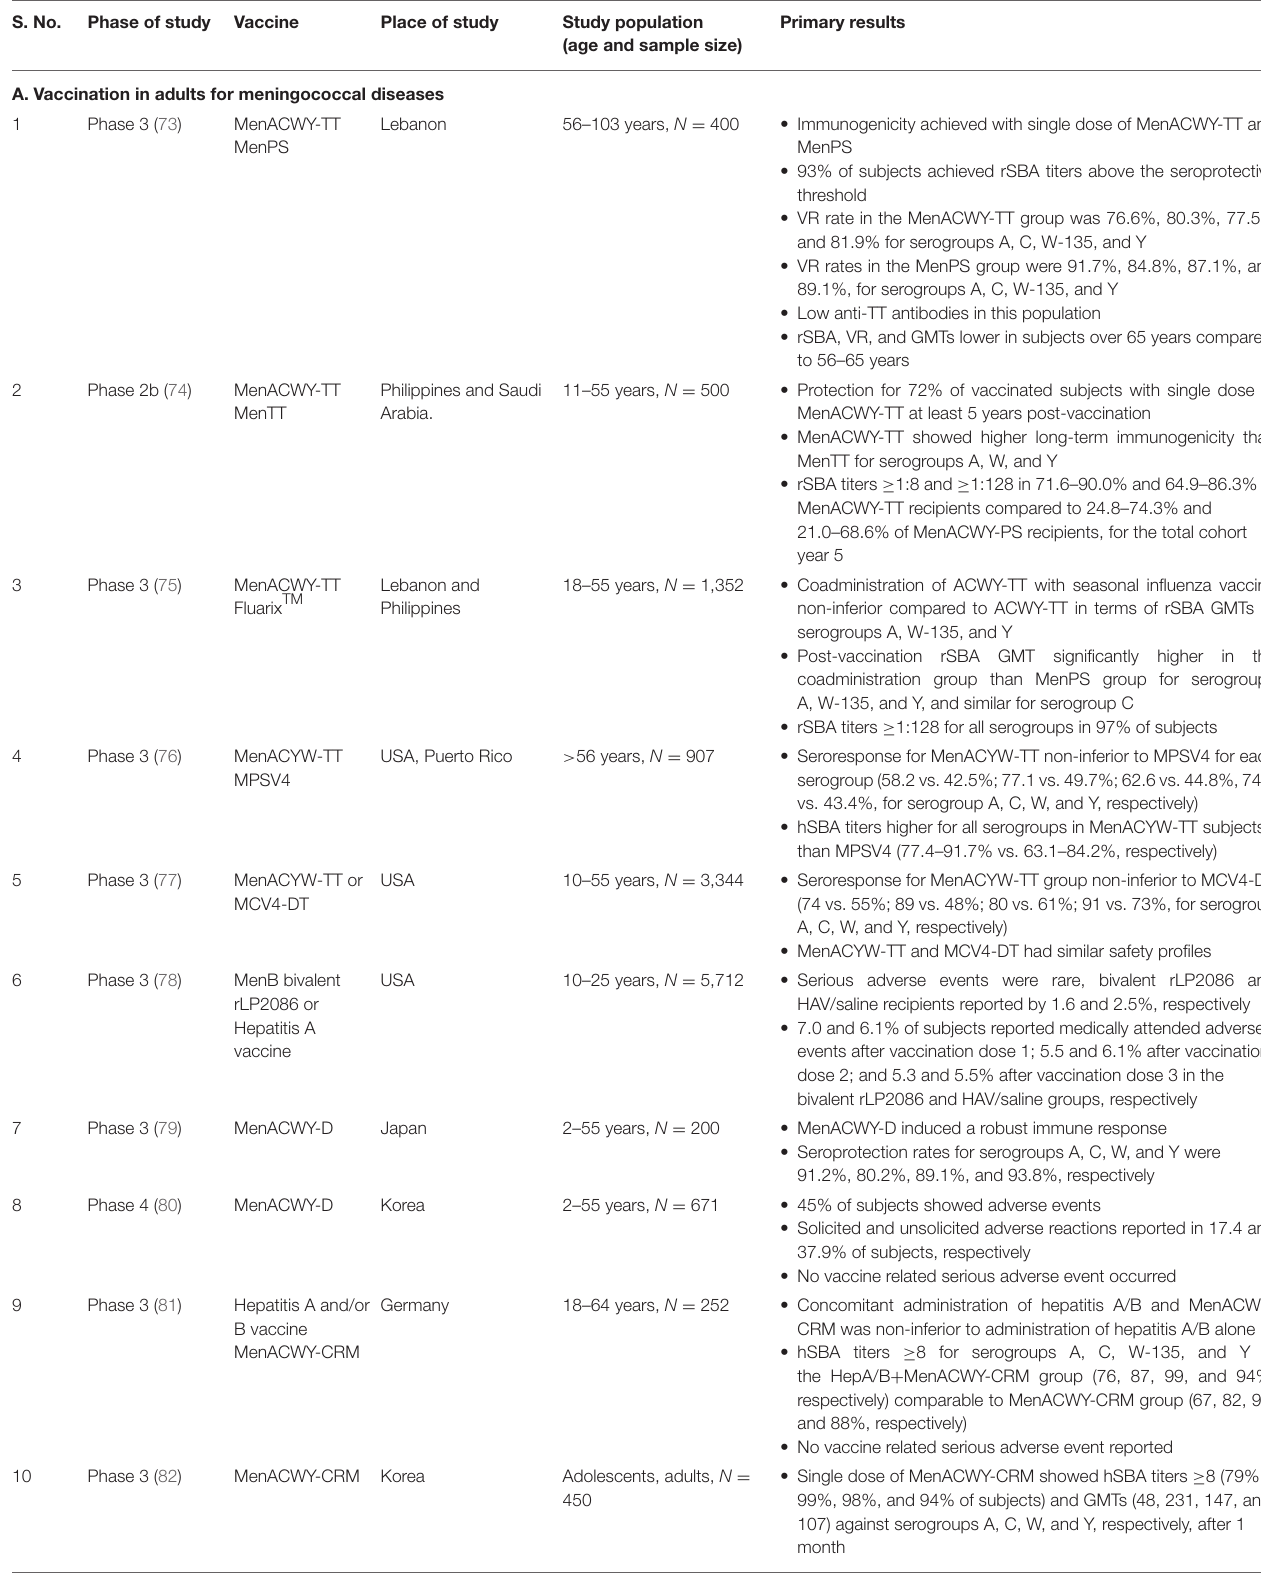
TABLE 2 | Clinical studies for vaccination in adults. S.